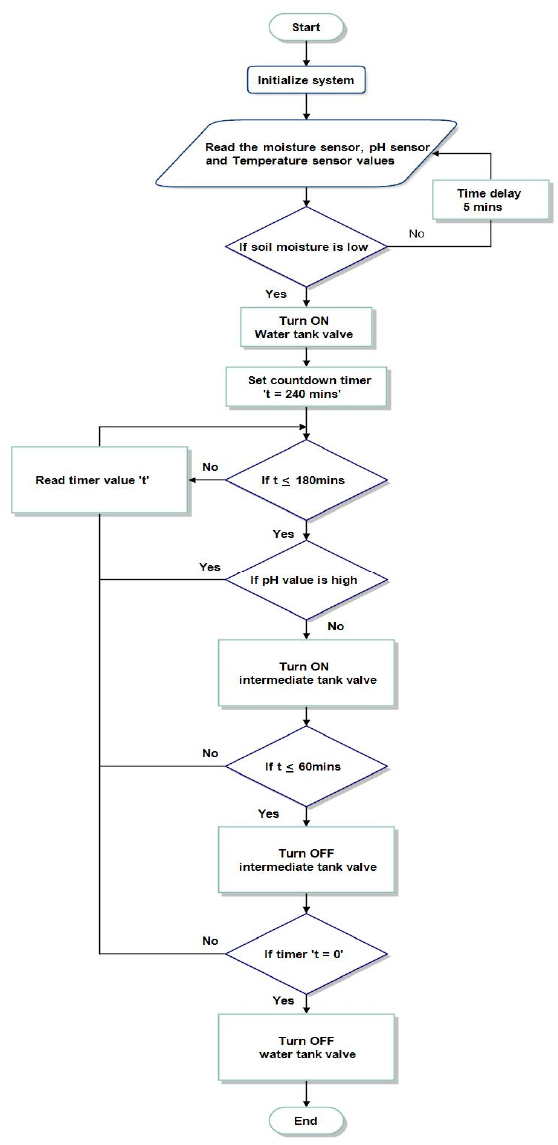
Figure 3. Flowchart of the automated drip irrigation process.